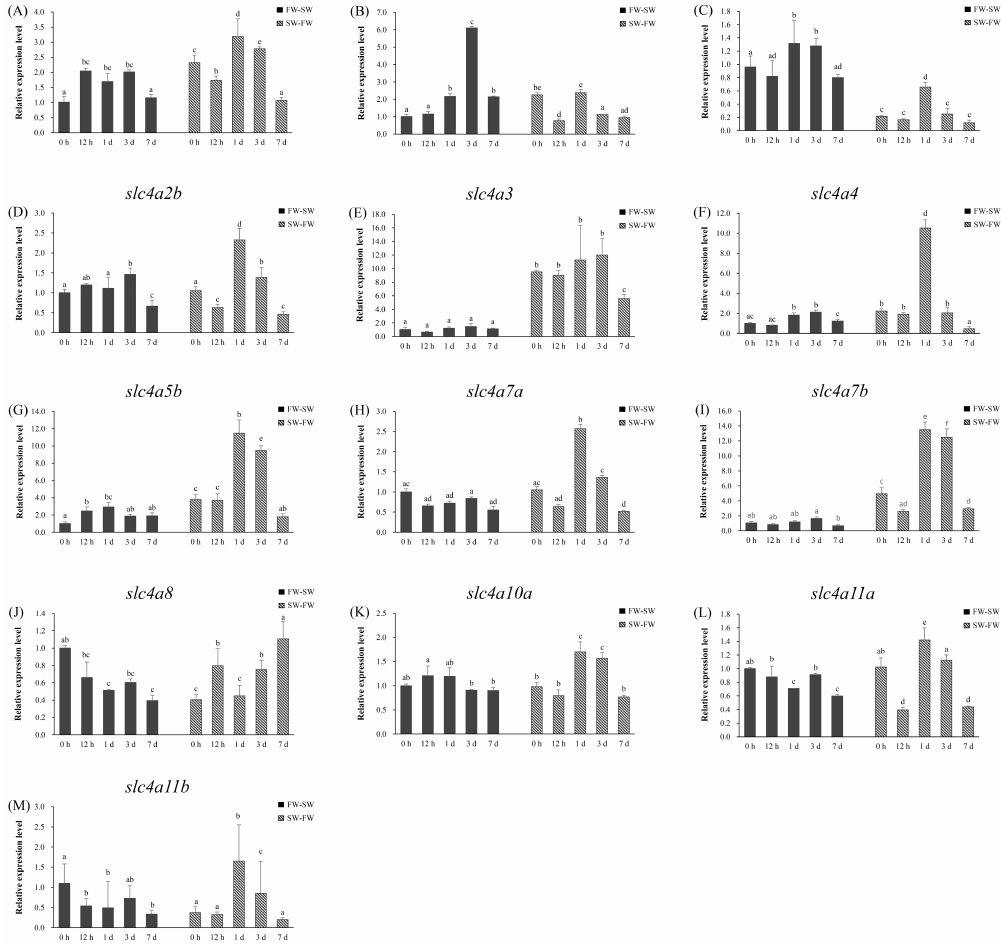
Figure 8. Expression of slc4 genes in gill of spotted sea bass after freshwater-saltwater (FW-SW) and SW-FW transfer. ( A – M ): slc4a1a – slc4a11b . Fish were transferred from FW to SW or SW to FW as control at 0 h. Significant differences ( p < 0.05) were indicated with different letters.